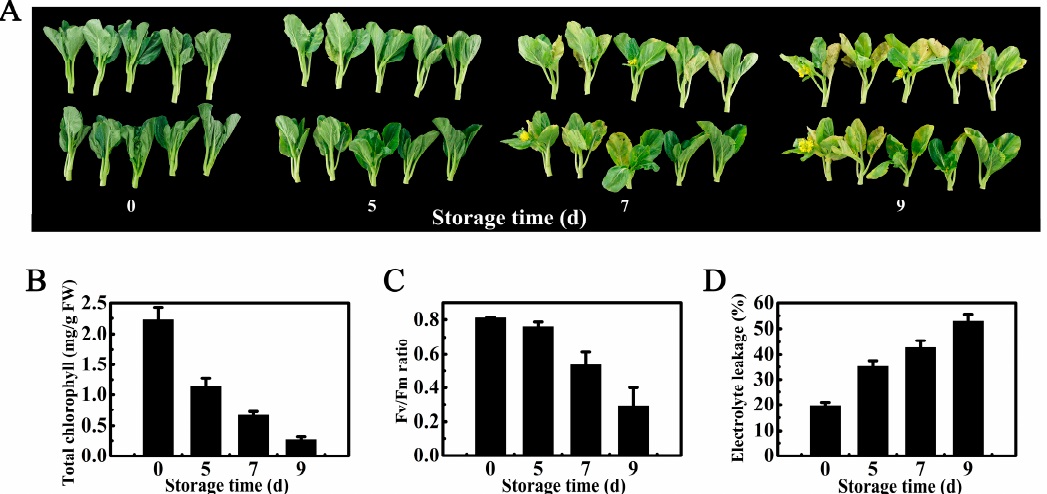
Figure 1. ( A ) Appearance of Chinese flowering cabbage during 9 days of storage at 15 °C; ( B – D ) Changes in total chlorophyll content, Fv/Fm ratio, and relative electrolyte leakage during postharvest leaf senescence. Data represent mean values from three biological replicates (±S.E.).